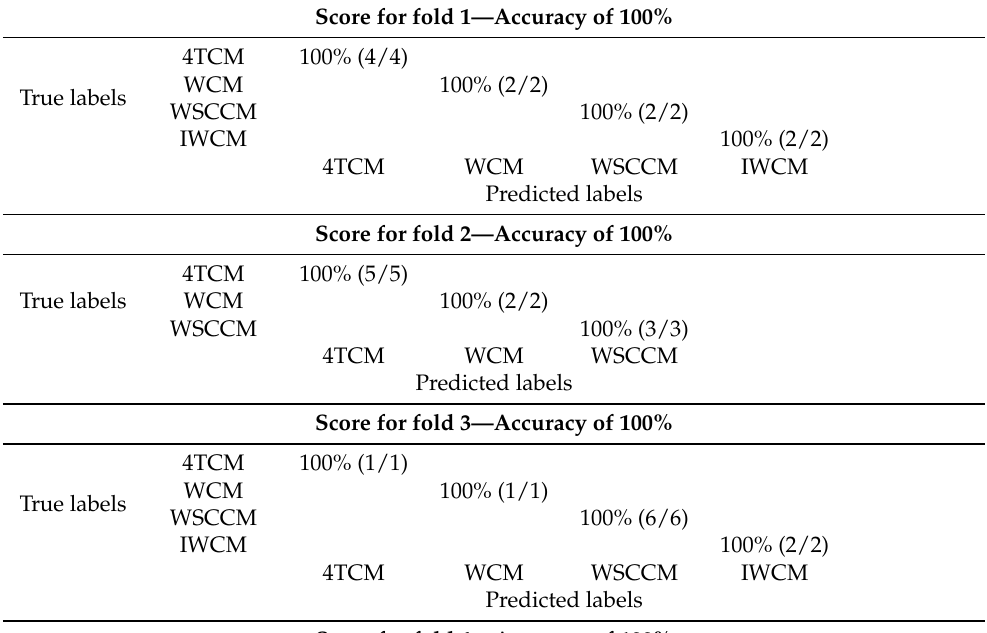
Table 5. A total of 15 folds were applied on the dataset, which means in each fold 1/15 of the dataset is used for testing and the rest 14/15 is used for training independently. For each fold, a confusion matrix is drawn, and all confusion matrices show 100% accuracy of